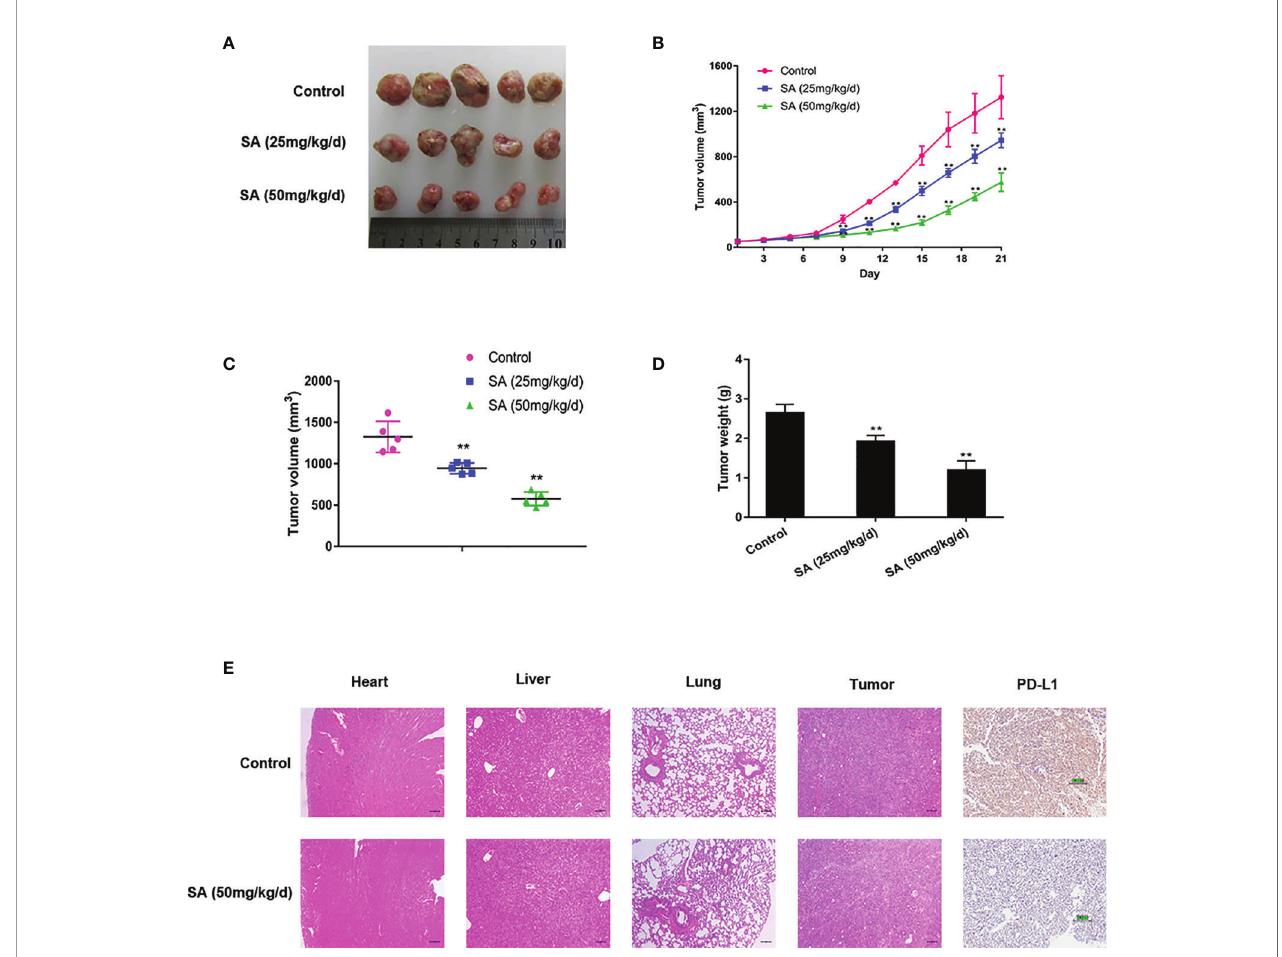
FIGURE 4 | SA inhibits TNBC tumor growth. (A) Tumor tissues collected at the end point. (B) Tumor volumes in xenograft models during the experiment and measured every three days (Compared to the control group, ** p < 0.01). (C) Tumor volumes in xenograft models at the end point (Compared to the control group, ** p < 0.01). (D) Tumor weights in xenograft models at the end point (Compared to the control group, ** p < 0.01). (E) Representative images of HE staining of normal tissues and IHC analysis of PD-L1 after SA